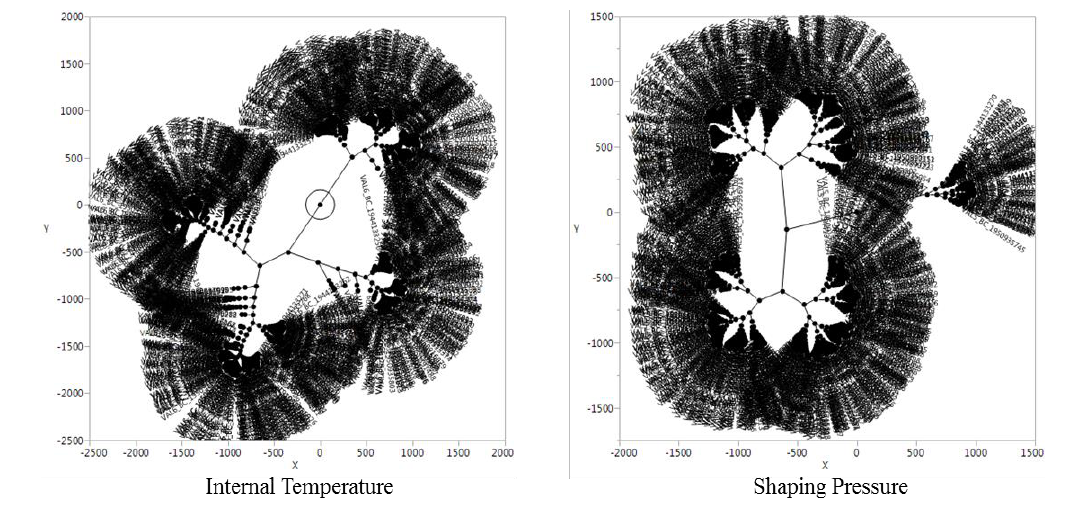
Figure 3. Constellation chart.